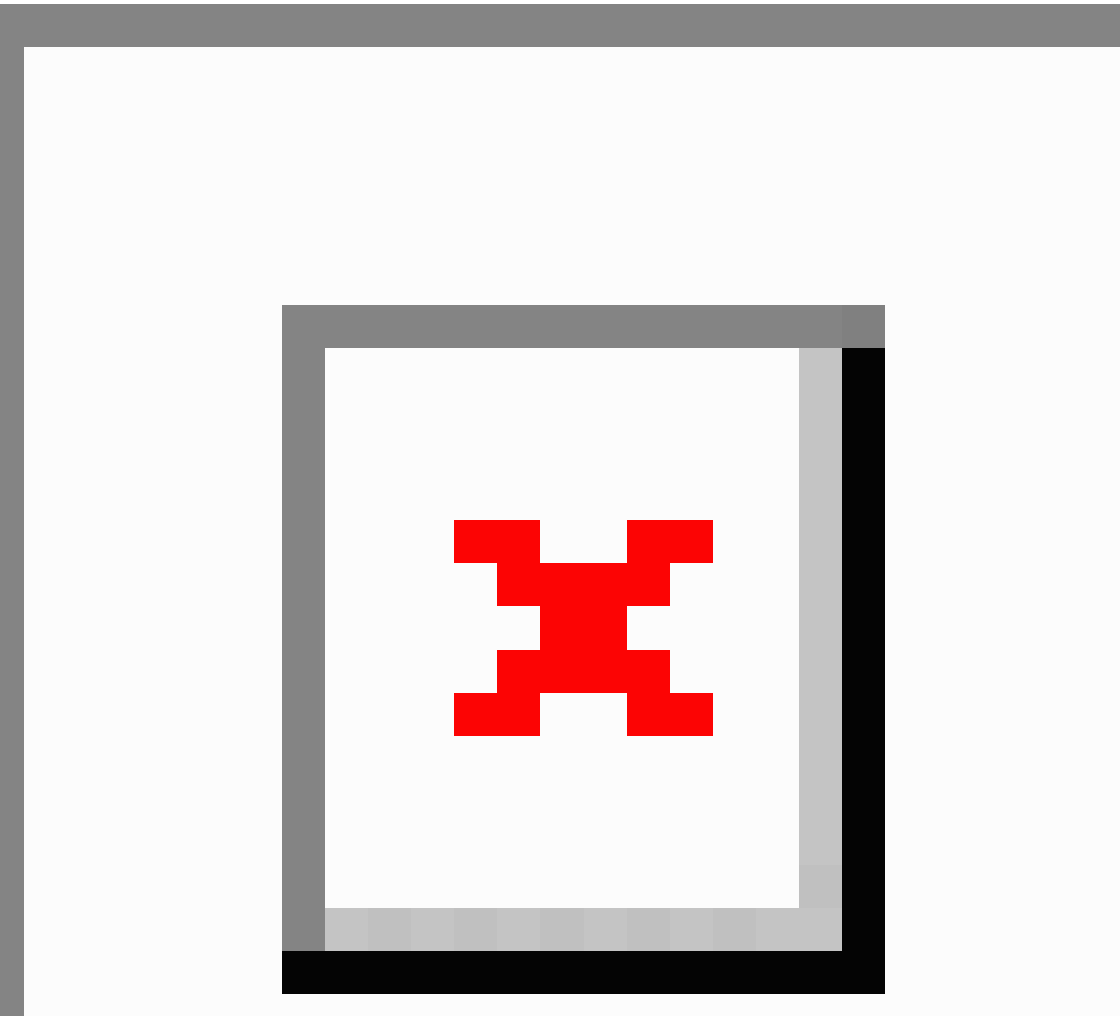
Figure 6. Left: latent growth trajectory for weekly alcohol consumption by condition after 6 months follow-up. Right: latent growth trajectory for frequency of binge drinking by condition after 6 months